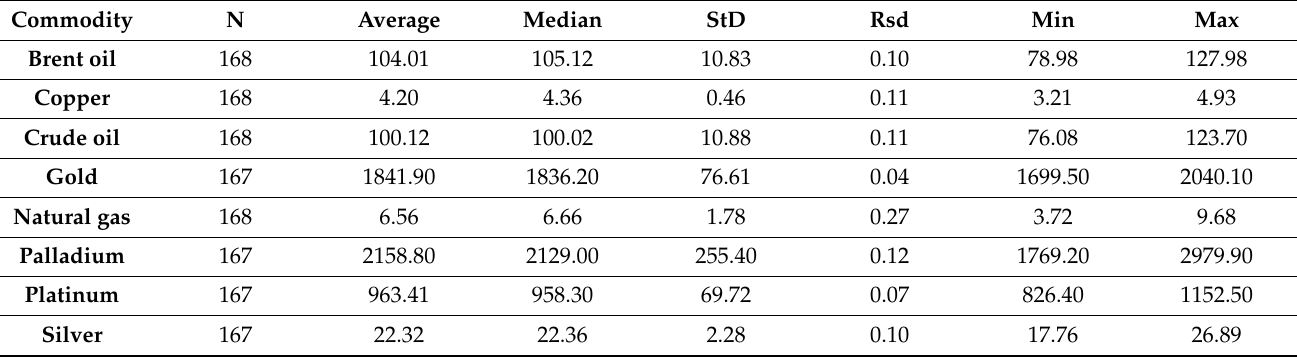
Table 8. Descriptive statistics of variables (1 January 2022–31 August